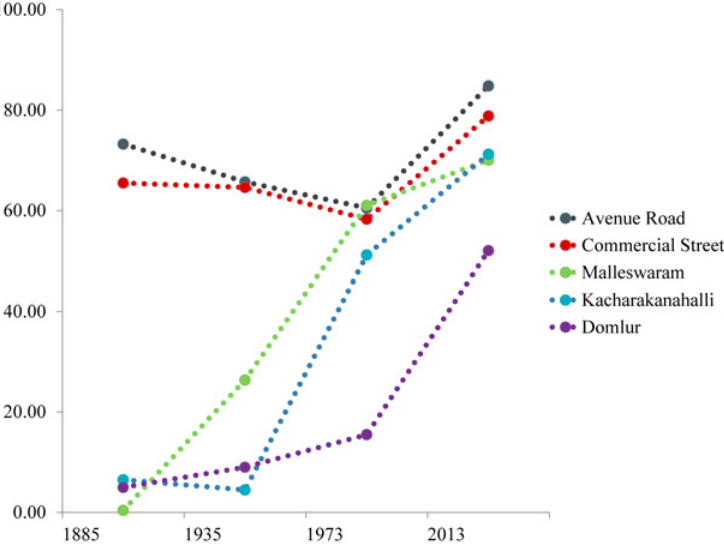
Figure 10. Variation in the percentage of urban cover across time for the five study location grids in